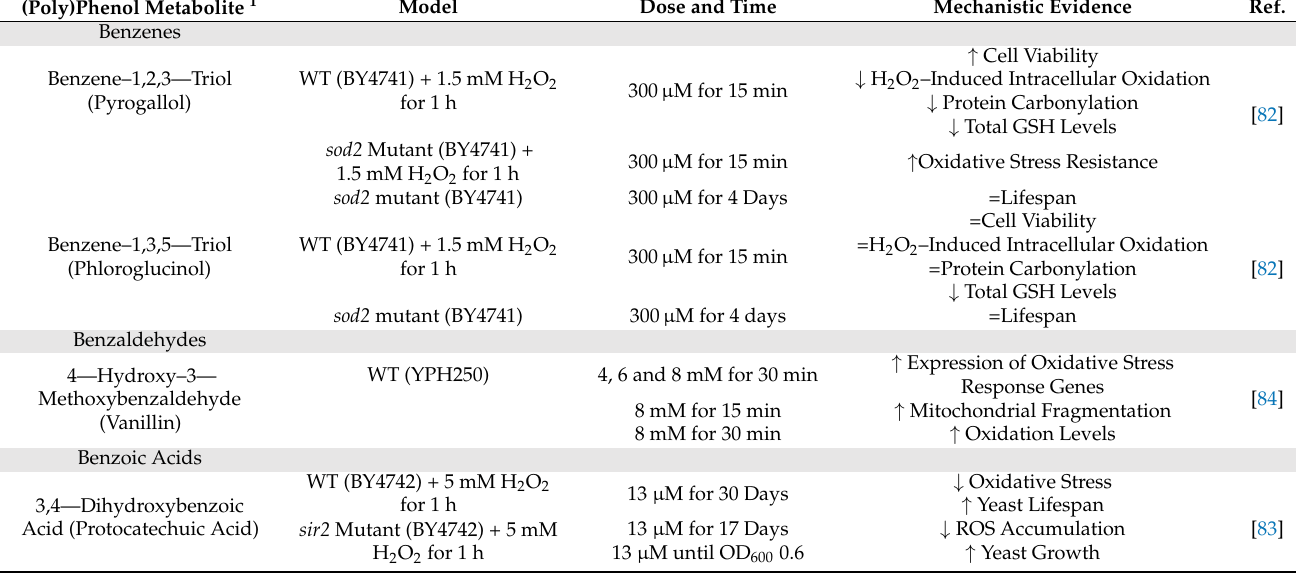
Table 2. Effects of low molecular weight (poly)phenol metabolites on Saccharomyces cerevisiae cells submitted to oxidative stress or in oxidative stress—related